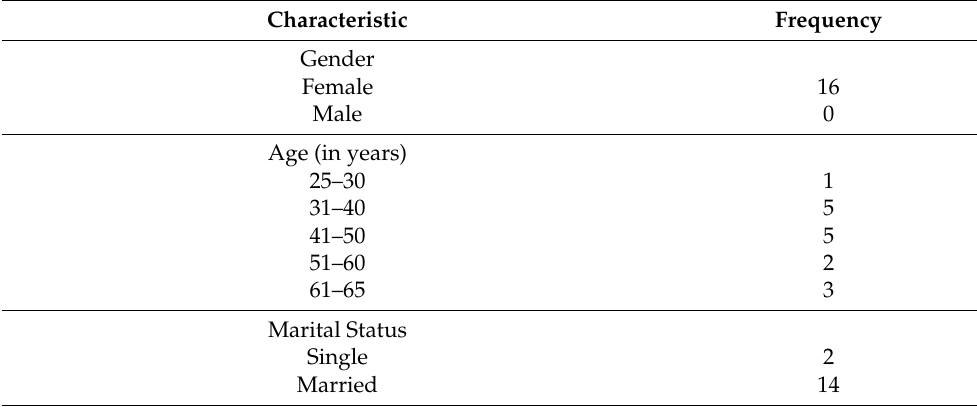
Table 2. Participants’ characteristics ( n =